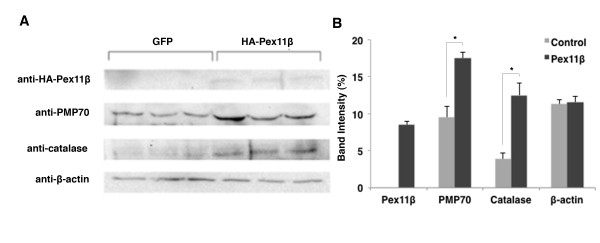
Overexpression of HA-Pex11β in A6 cells increased catalase and PMP70 protein levels. Western blotting revealed elevated proteins levels of catalase and PMP70 following the transfections of HA-Pex11β, but not GFP, in three samples of A6 cells (A). An HA antibody confirmed the translation and presence of HA-Pex11β in transfected cells (right 3 lanes) versus GFP transfected control cells (left 3 lanes). Catalase and PMP70 antibodies also displayed altered band intensities of each respective protein in HA-Pex11β transfected cells (right 3 lanes) versus GFP transfected cells (left 3 lanes). Protein loading in each lane was confirmed via a β-actin antibody. The Western blot signals were digitized and data were quantified and analyzed to statistically compare protein levels (B). There was a significant increase in the levels of catalase and PMP70 following overexpression of Pex11β, while there was no difference in the levels of β-actin. Statistical relevance of discrepancies between groups (asterisks) was assessed by an independent samples t-test. P < 0.05, n = 3. Values presented are the means ± SE.